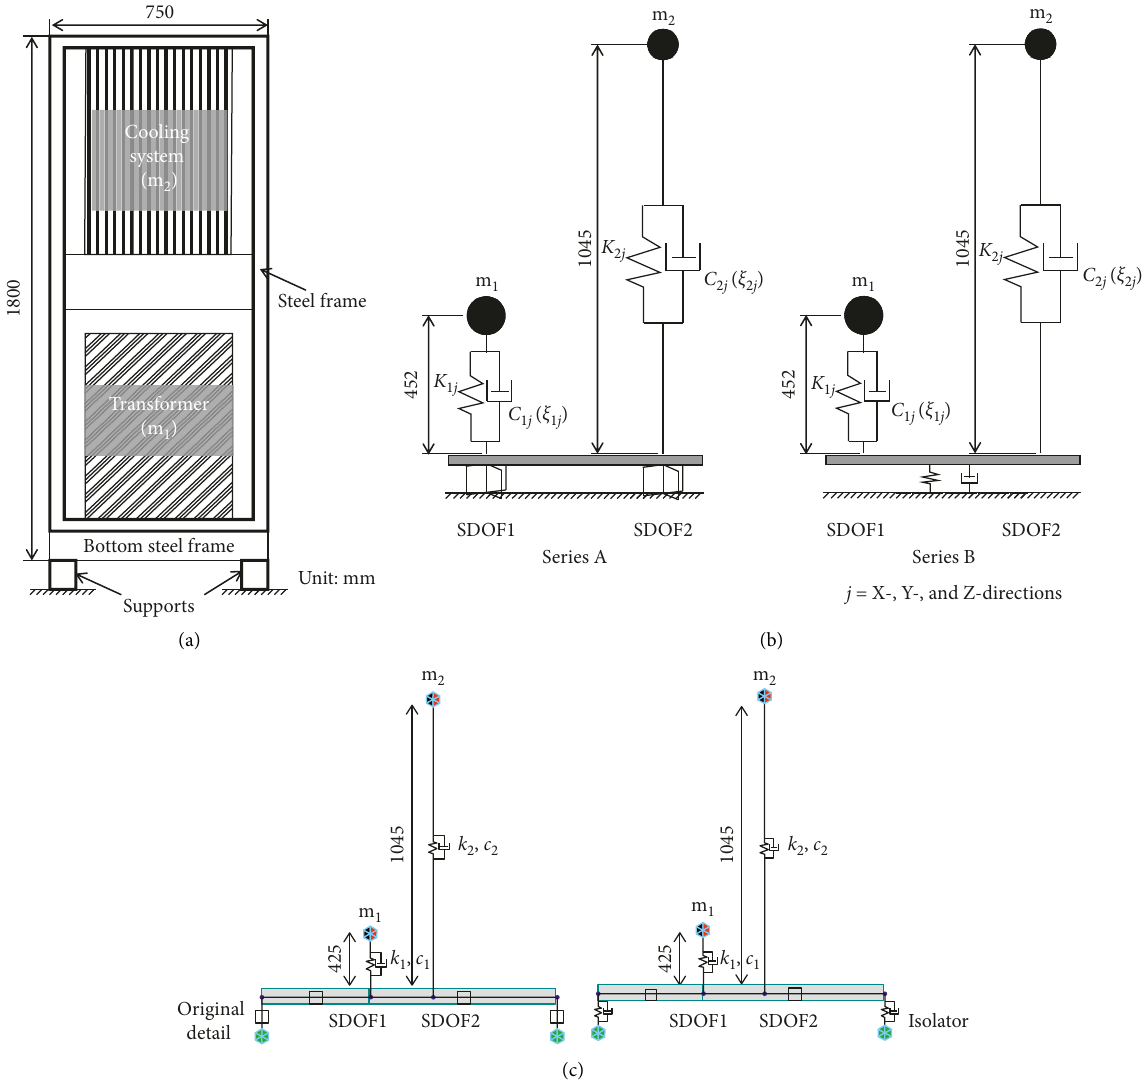
Figure 18: Analytical model used in the analysis program. (a) Configuration of the UPS. (b) Idealization of the model. (c) Schematic diagram of the model by MIDAS